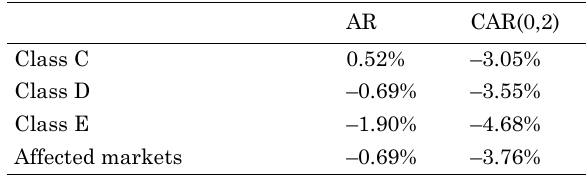
table 8. event study results for the adjustment